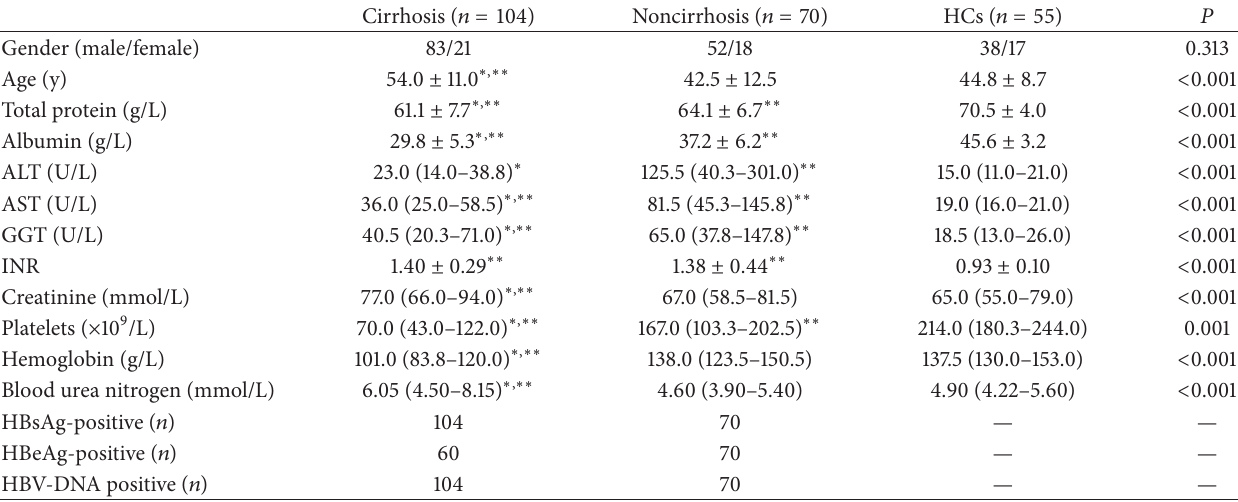
Table 1: Demographic and clinical characteristics of the subjects.